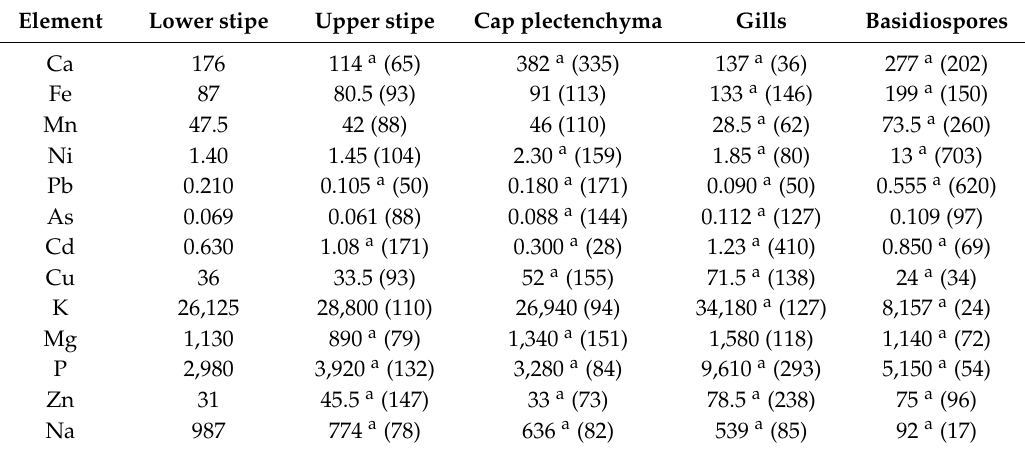
Figure 3. Variation in concentrations of minerals from the lower stipe (L) of Kuehneromyces mutabilis basidiomes (100%) via upper stipe (U), cap plectenchyma (C), and gills (G) to basidiospores (S). Values are arithmetic means for sets of minerals with similar modes of passage (refer to Table 3). Adapted from Gramss and Voigt [61]. Table 3. Up ‐ and down ‐ regulated mineral concentrations (mg kg − 1 DW) across sporulating basidiomes of the mushroom K. mutabilis grown on trunk sections of European beech embedded into non ‐ contaminated soil C org 8.9%. ( ), quotients calculated from mineral concentrations of the actual to the preceding column expressed in percent.